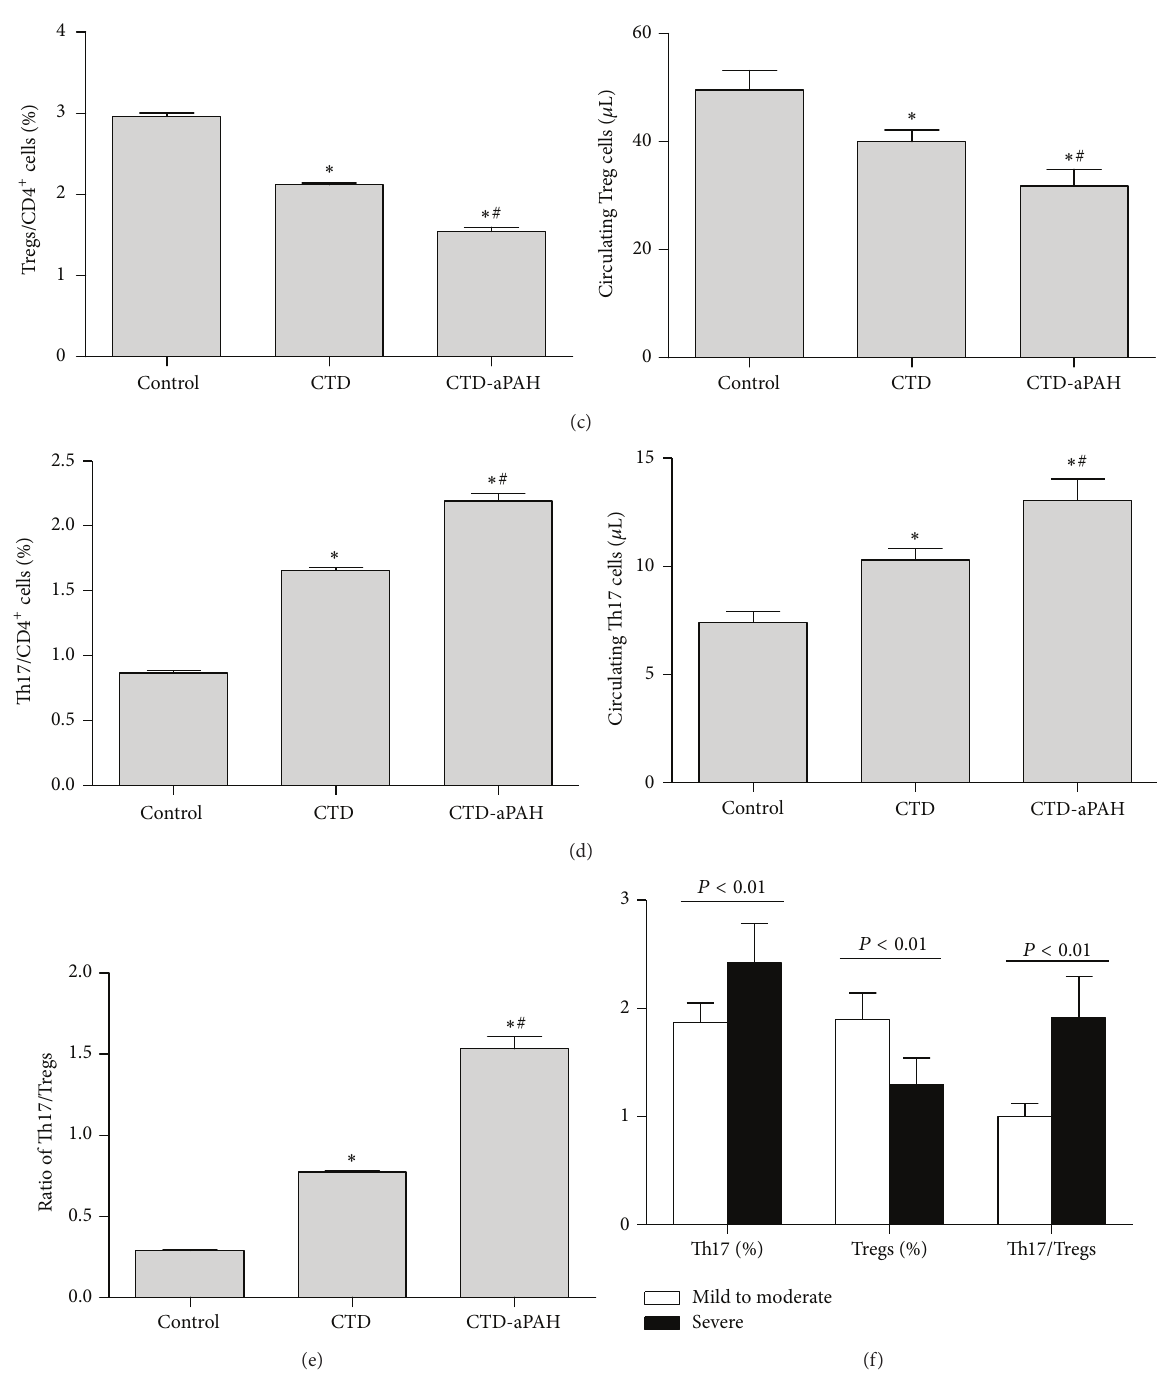
Figure 1: Frequencies and absolute counts of circulating Treg and Th17 cells as well as the ratio of Th17/Treg in CTD and CTD-aPAH patients andhealthycontrols.PBMCsfromstudiedsubjectswerestainedwithlabeledanti-humanantibodiesasdescribedinSection 2.Flowcytometry dot-plots showed that the gating strategies were used in identification of Treg (gated on CD4 + cells for detection of CD4 + CD25 + Foxp3 + and CD4 + CD25 + CD127 − cells) and Th17 cells (gated on CD4 + cells for detection of CD4 + IL-17 + cells). (a) The dot-plots showed the gating strategies of circulating CD4 + CD25 + Foxp3 + Treg, CD4 + CD25 + CD127 − Treg and Th17 cells in control, CTD and CTD-aPAH groups. (b) Statistical analysis revealed the frequencies of CD4 + CD25 + Foxp3 + Treg and CD4 + CD25 + CD127 − Treg populations among the CD4 + T cells in healthy controls ( 𝑛 = 20 ) and in patients with CTD ( 𝑛 = 18 ) or CTD-aPAH ( 𝑛 = 23 ). (c) Frequencies (left) and absolute counts (right) of circulating Treg cells (CD4 + CD25 + Foxp3 + ) in control, CTD and CTD-aPAH groups. (d) Frequencies (left) and absolute counts (right) of circulating Th17 cells in control, CTD and CTD-aPAH groups. (e) The ratios of Th17/Treg in control, CTD and CTD-aPAH groups. (f) Th17 and Treg cells frequencies and the ratios of Th17/Treg in subgroups of mild to moderate CTD-aPAH and severe CTD-aPAH. ∗ Compared with control group, 𝑃 < 0.05 ; # Compared with CTD group, 𝑃 < 0.05